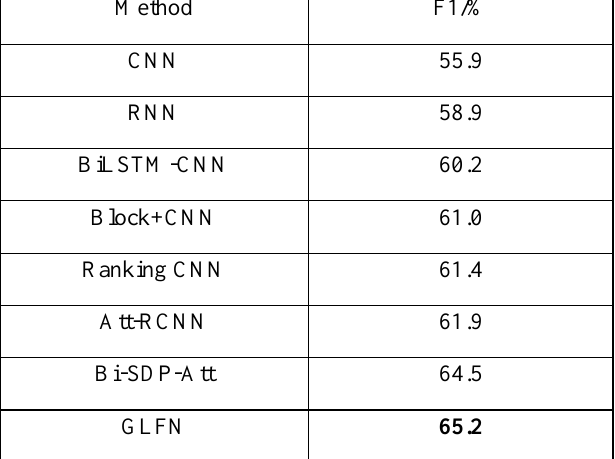
Table 6. F1 values of 8 methods on KBP37 data set